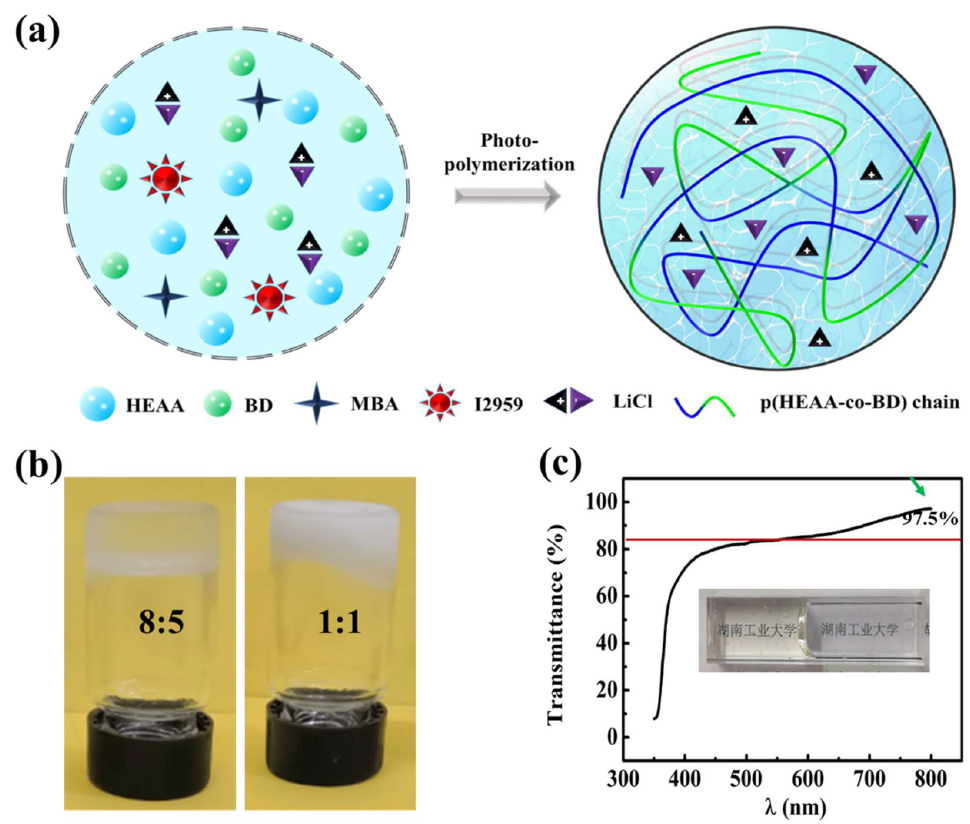
Figure 1. ( a ) Schematics of preparation of LiCl/p(HEAA− co −BD) antifreeze conductive hydrogel; ( b ) Frost resistance of HEAA hydrogels with different concentrations of HEAA at −20 °C; ( c ) The transmittance of LiCl/p(HEAA−co−BD) antifreeze conductive hydrogel in a colorimetric dish.